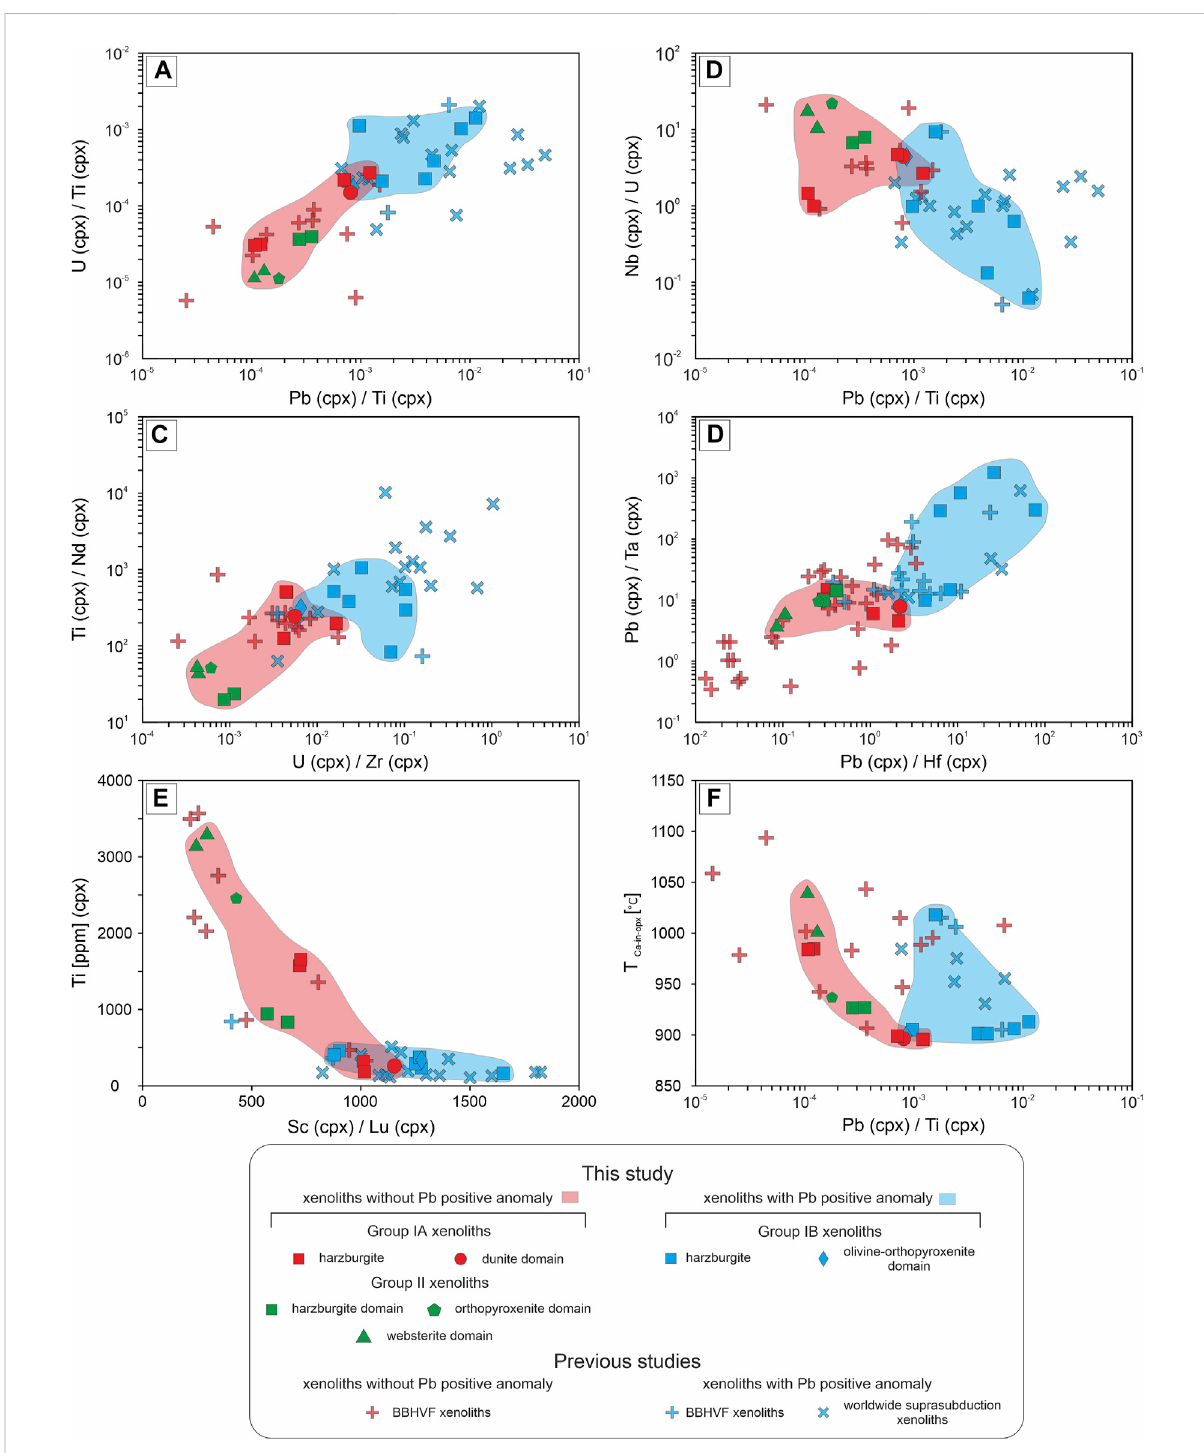
FIGURE 9 Relationshipsbetween (A) Pb/Tivs.U/Ti; (B) Pb/Tivs.Nb/U; (C) U/Zrvs.Ti/Nd; (D) Pb/Hfvs.Pb/Ta; (E) Sc/Luvs.Ti (F) Pb/Tivs.T Ca-in-opx ,whereall traceelementcompositionandratiosrefertoclinopyroxenes.ThermometerofT Ca-in-opx isafterNimisandGrütter(2010).PublishedBakony-Balaton Highland Volcanic Field (BBHVF) upper mantle xenoliths: Embey-Isztin et al., 1989; 2001; 2014; Downes et al., 1992; Bali et al., 2002; 2007; 2008; Hidas et al., 2007; 2010; Nédli et al., 2009; Dobosi et al., 2010; Berkesi et al., 2012; Créon et al., 2017b. Worldwide supra-subduction xenoliths with Pb positive anomalies are taken from Grégoire et al., 2001; Ishimaru et al., 2007; Aradi et al.,